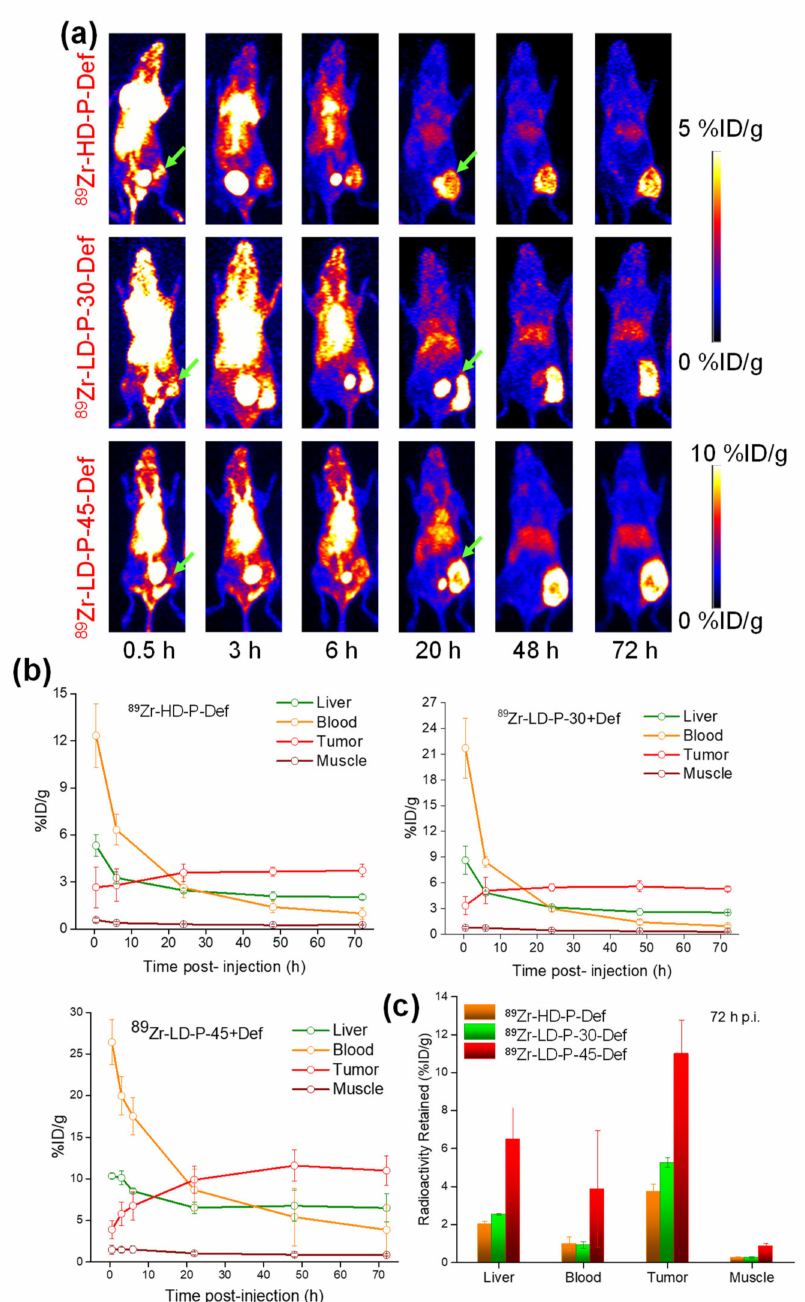
Figure 1. In vivo positron emission tomography (PET) imaging and biodistribution study: ( a ) se- rial maximum intensity projection (MIP) images, ( b ) time–activity curves, ( c ) and comparison of radioactivity retained in liver, blood, tumor and muscle of 89 Zr-labeled linear pHPMAs; HD-P + Def ( M w = 27,800 g/mol, Ð = 1.74), 89 Zr-LD-P-30 + Def ( M w = 33,300 g/mol, Ð = 1.06) and 89 Zr-LD-P-45 + Def ( M w = 45,200 g/mol, Ð = 1.07). Reprinted with permission from [39]. Copyright (2017) The Royal Society of